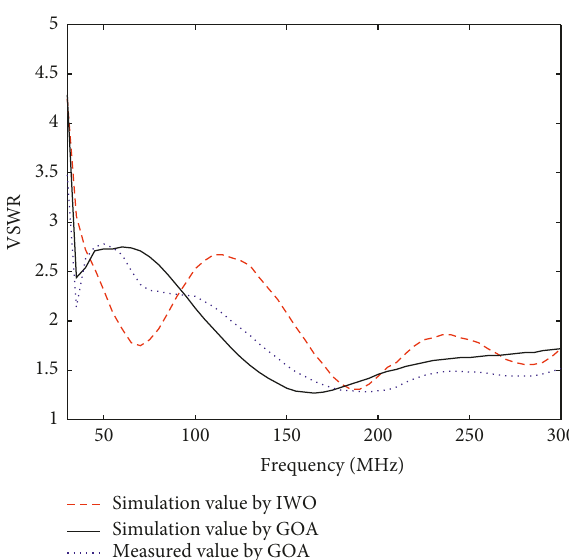
Figure 18: The VSWR of 10:1 scaled optimized whip antenna.